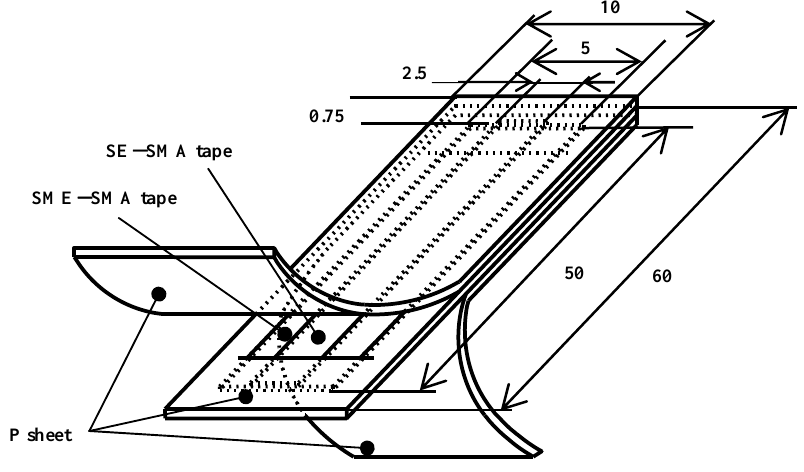
Figure 2. Structure of SMC composed of SME-SMA tape, SE-SMA tape and SMP sheet.